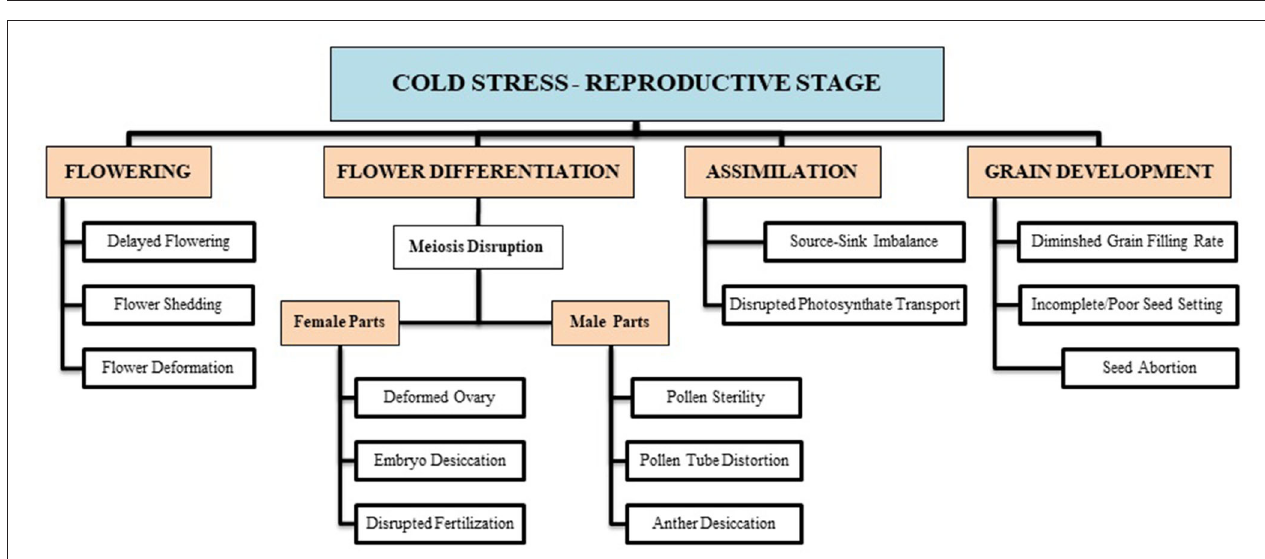
FIGURE 2 | Cold-induced reproductive deformities are briefly illustrated with respect to certain growth stages (i.e., flowering, differentiation, assimilate transport, grain filling, etc.). These growth disruptions result in a substantial decline in final wheat produce.